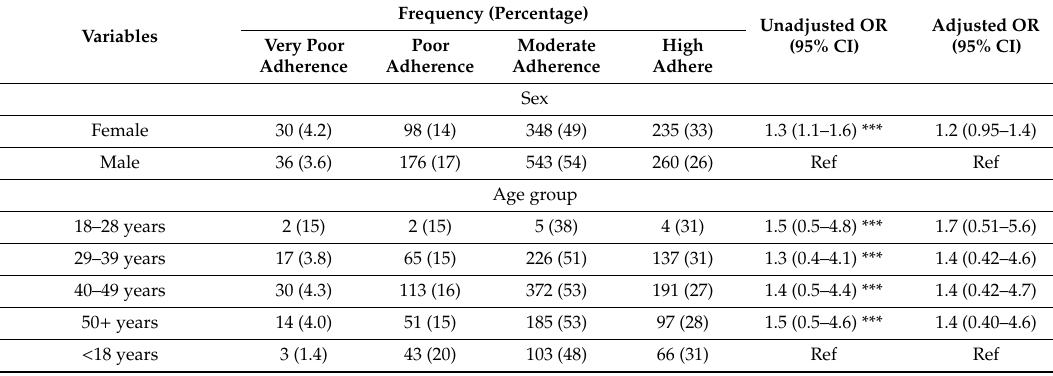
Table 3. Determinants of adherence to COVID-19 preventive health measures in the first stage of the outbreak,